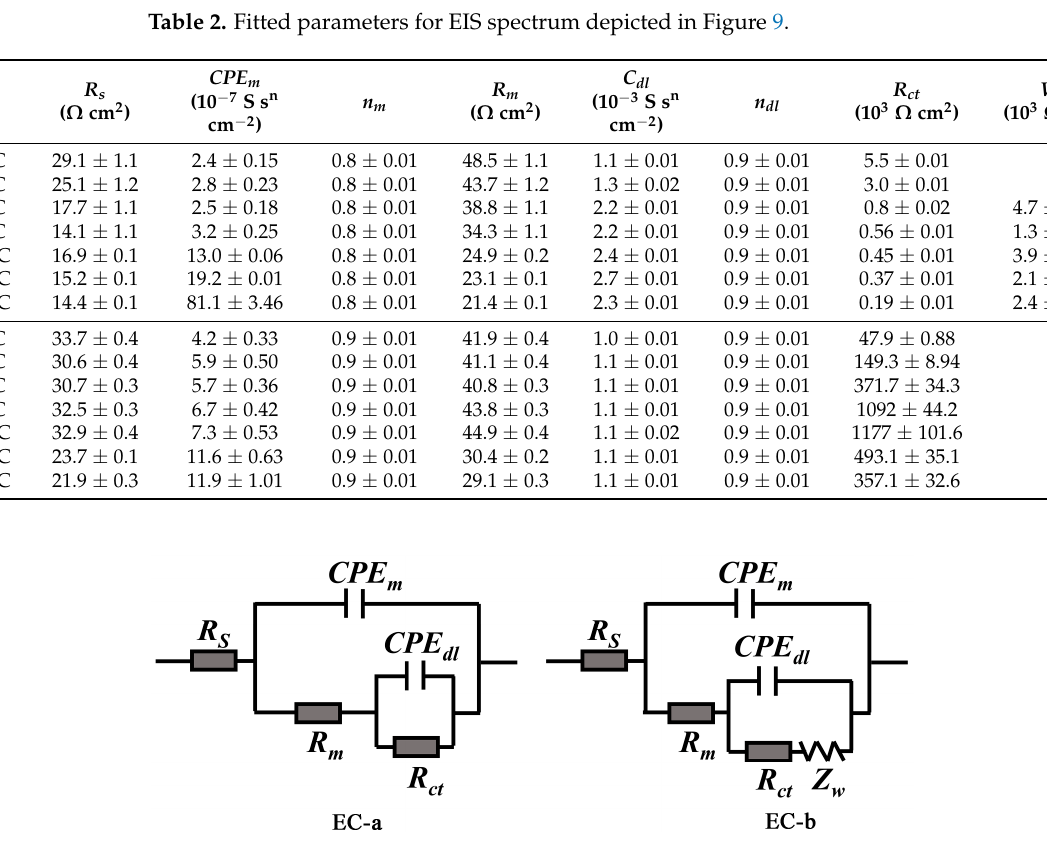
Figure 11. Equivalent electric circuits used for modeling the EIS results of Figure 10. Table 2. Fi tt ed parameters for EIS spectrum depicted in Figure 9.